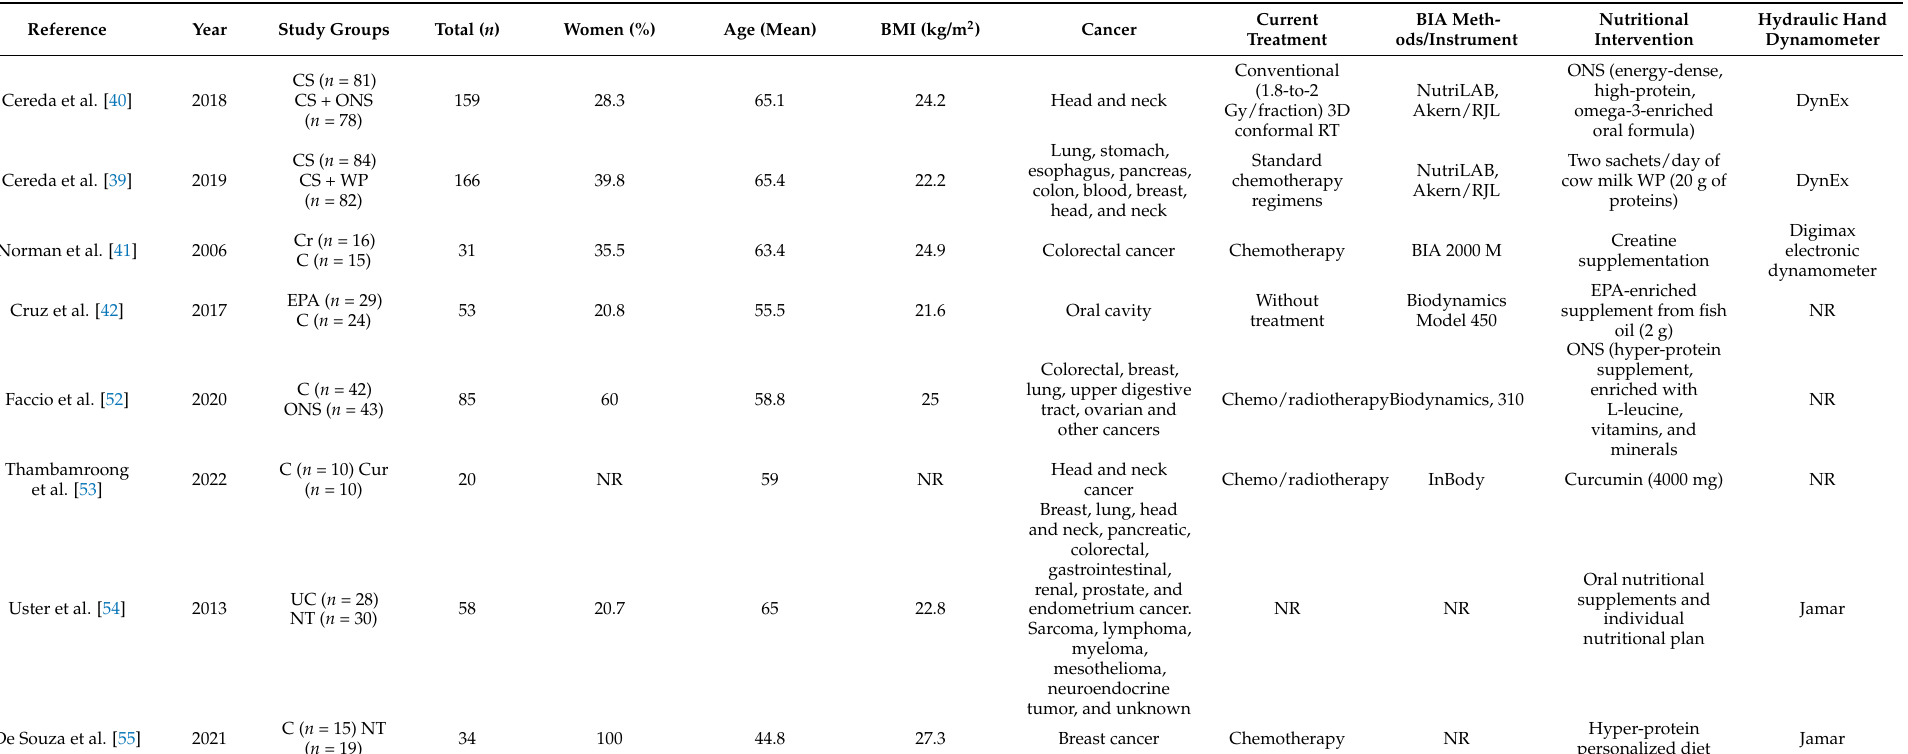
Table 1. Descriptive data of the study participants (N =